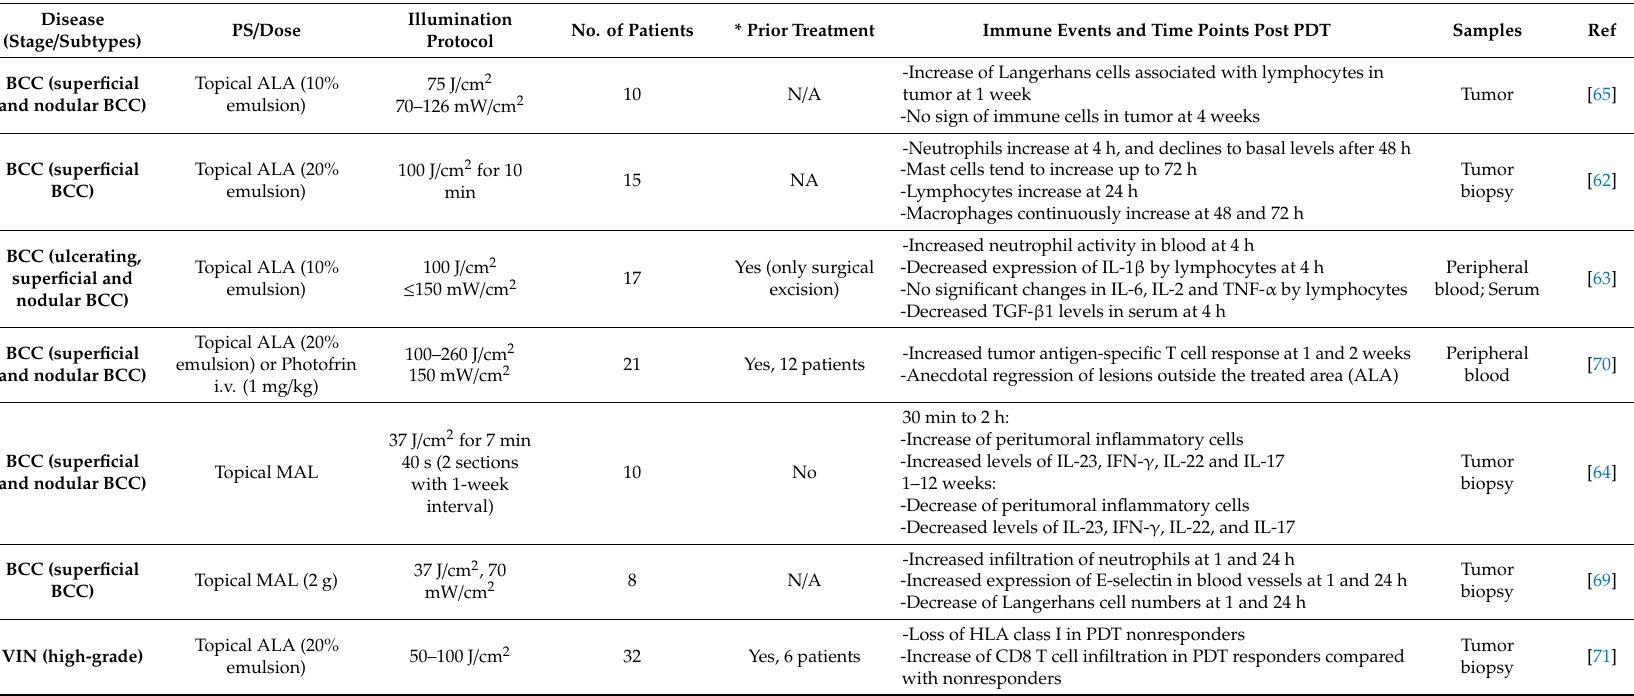
Table 3. Clinical studies investigating the immune response to PDT in cancer